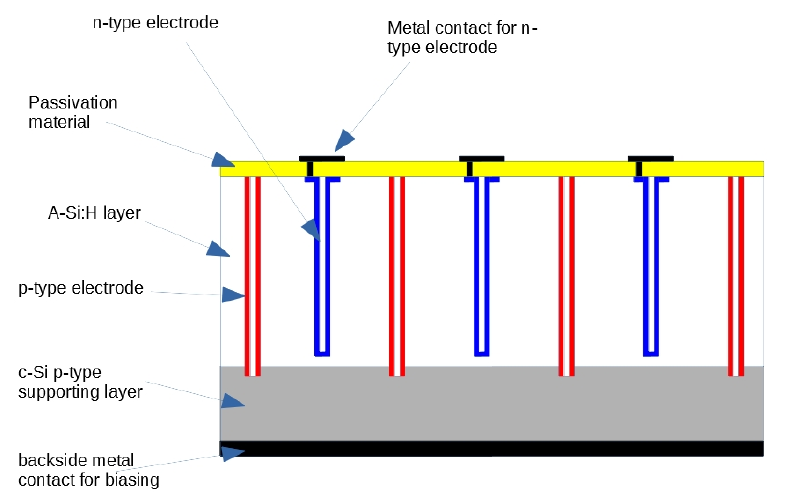
Figure 1. Baseline configuration of an a-Si:H detector. P-type electrodes are biased from the p-doped c-Si substrate, whereas n-type electrodes are connected to the readout